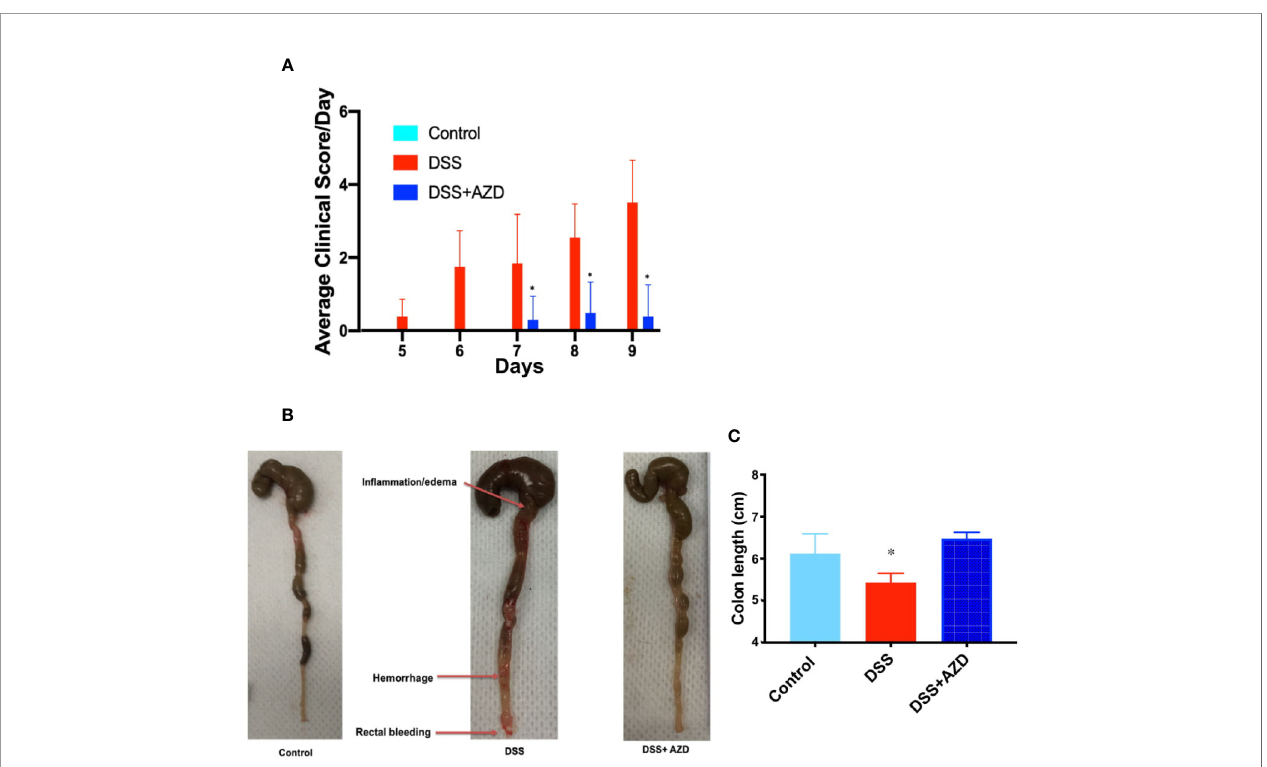
FIGURE 3 | (A) Enumerated clinical score representing fecal consistency, rectal bleeding, reduced mobility and general health of the animals over 9 days of treatment. (B) Representative images of colon morphology resected after 9 days. (C) Mean colon length at day 9. Mice were randomly divided into three treatment arms over 9 days i) vehicle group (n=5) given normal drinking water and peanut butter without drug; ii) dextran sodium sulfate (DSS) group (n=5) given 2% w/v DSS in drinking water and peanut butter without drug; iii) DSS+AZD3241 (n=5) given 2% w/v DSS in drinking water and AZD3241 @ 30 mg/kg in peanut butter. Different to the DSS group, (*p = 0.001). AZD3241 is abbreviated to AZD in this fi